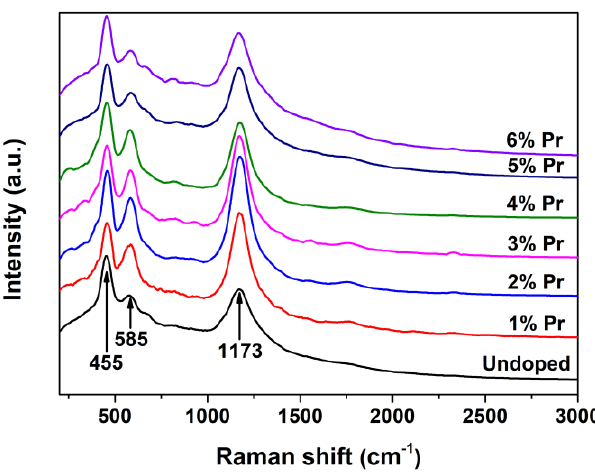
Figure 5. Raman spectra of Undoped CeO 2 and Pr−doped CeO 2 with different Pr contents.